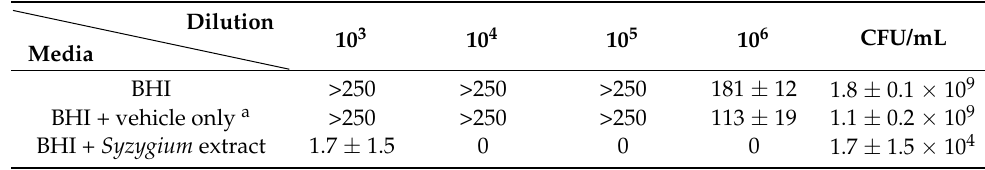
Table 5. The number of Cutibacterium acnes colonies per dilution of each media treated with the Syzygium formosum extract .